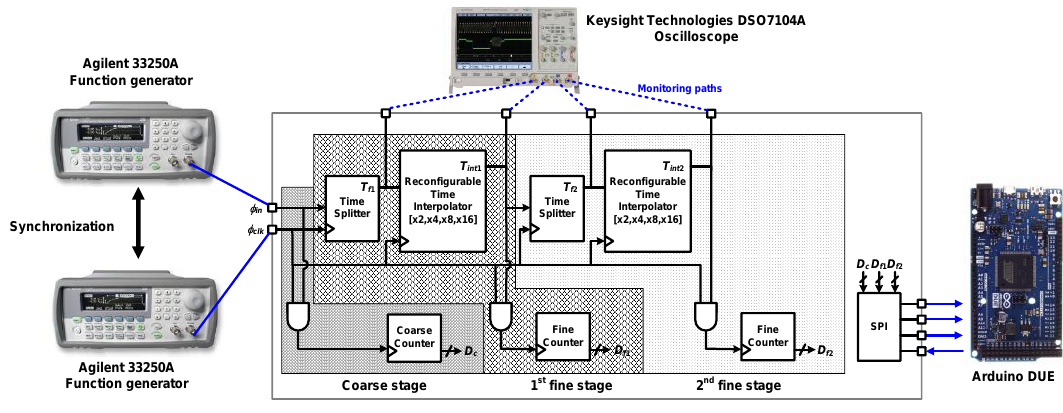
Figure 10. Measurement setup.